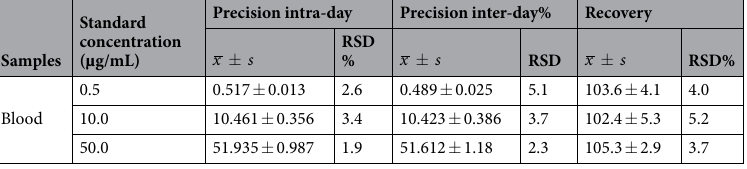
Table 4. Repeatability, Precision and Recovery of MDMA (n = 5).